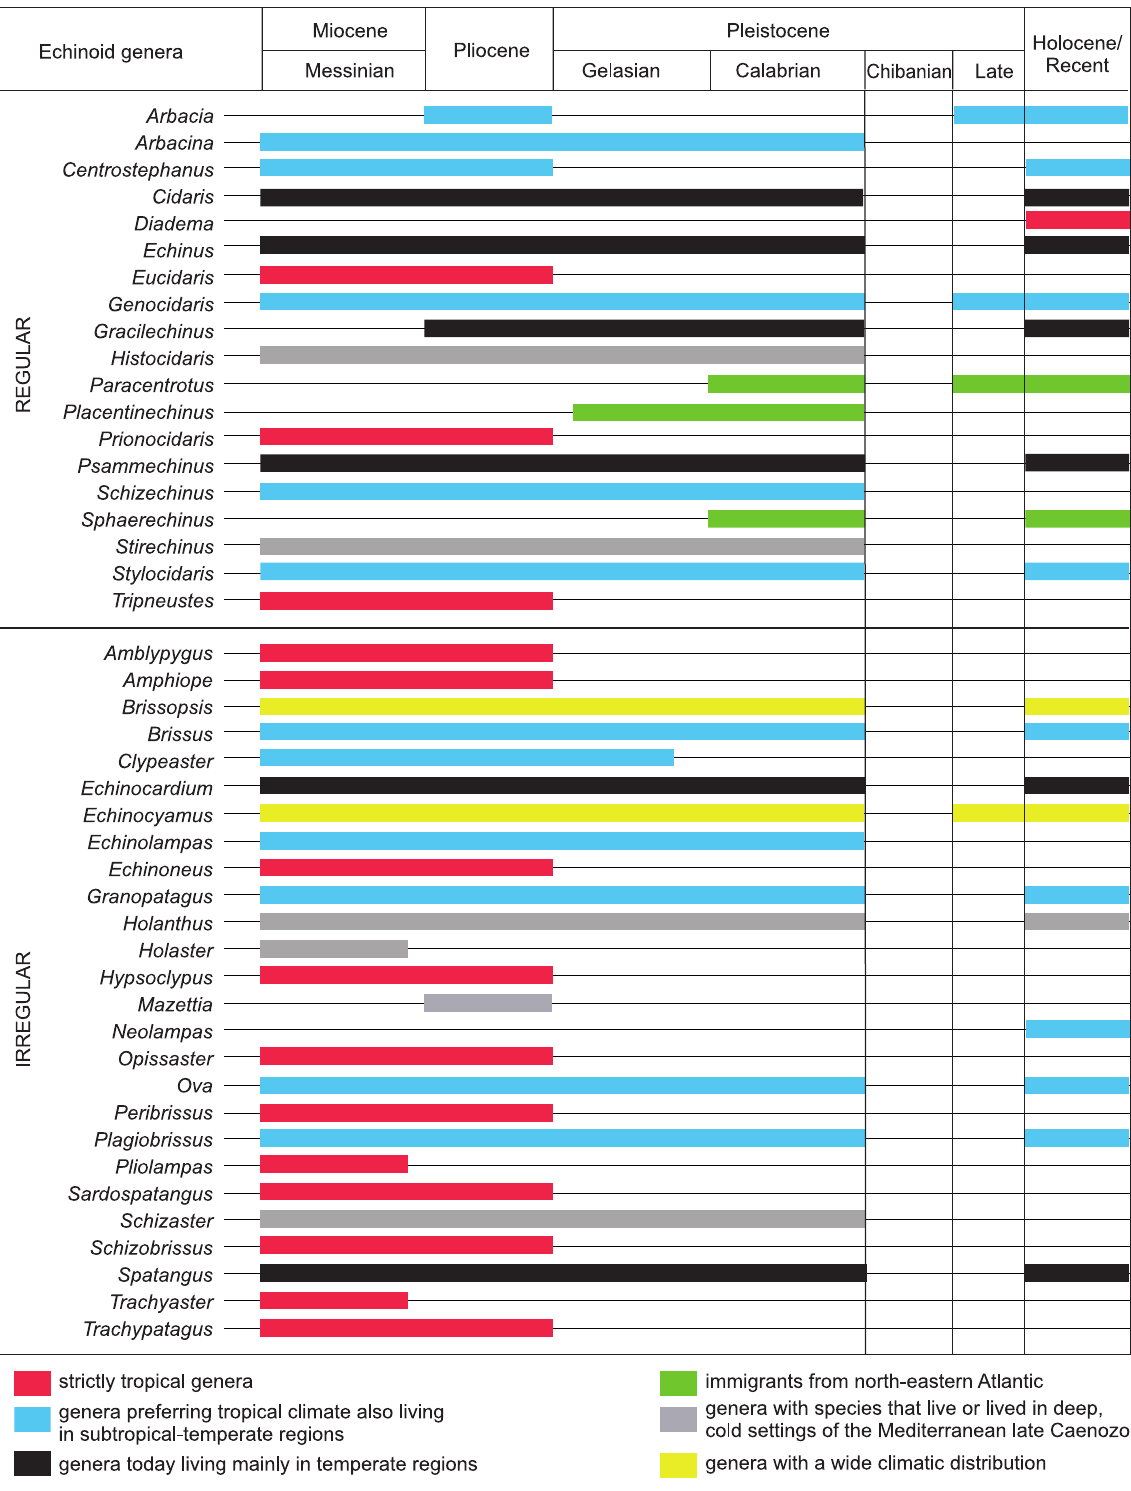
Fig. 5. Stratigraphic distribution and climatic preferences of regular and irregular echinoids recorded in the Miocene to Recent Mediterranean